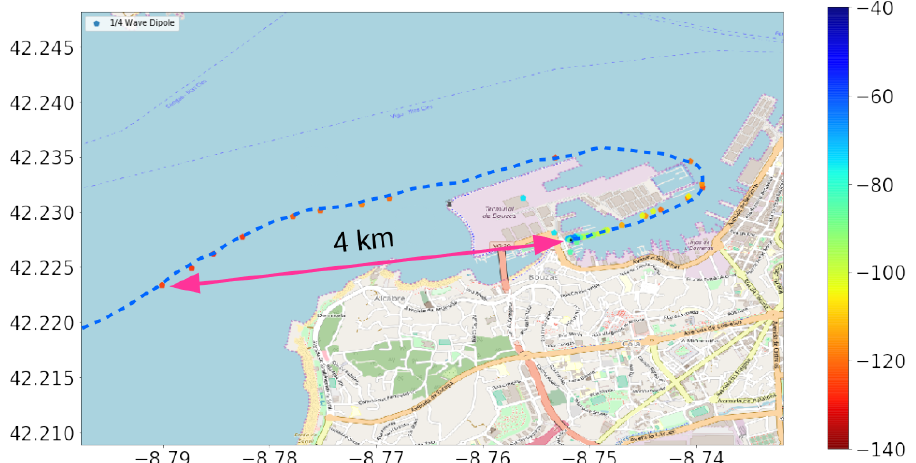
Figure 13. Coverage study in the open sea in terms of received RSSI